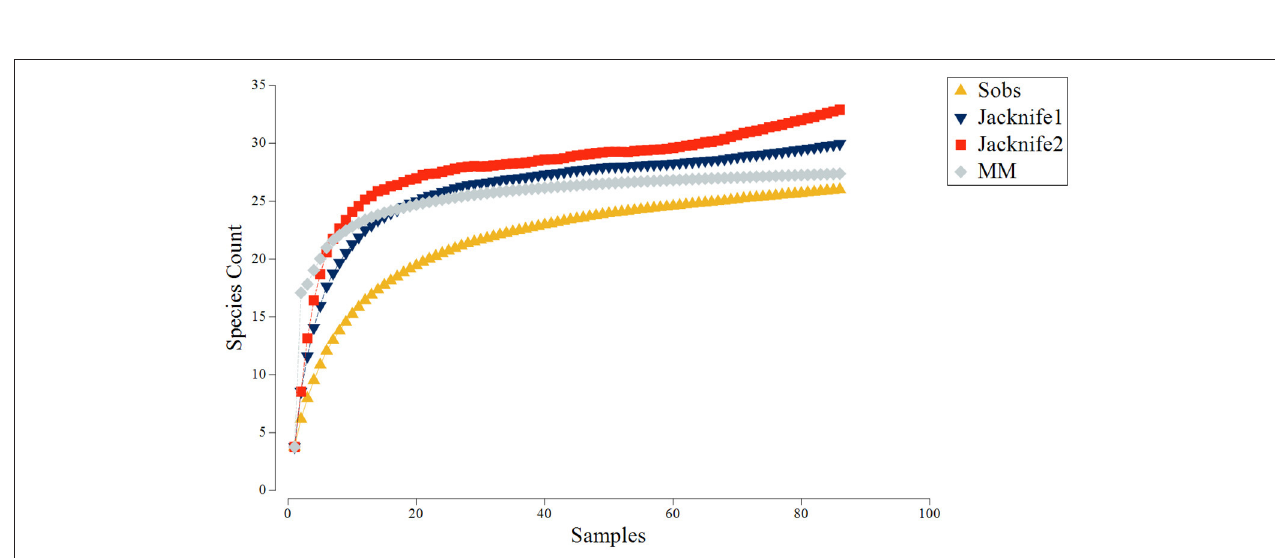
FIGURE 5 | Species accumulation curves derived from video samples collected in the Eastport MPA in 2015: Species observed (Sobs), Jacknife1, Jacknife2, and Michaelis-Menten (MM).